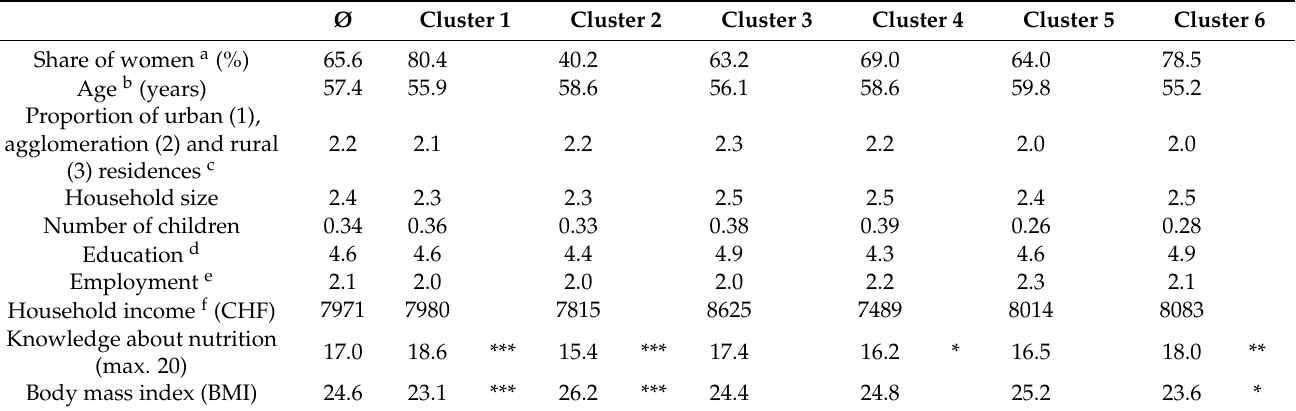
Table 3. Comparison of clusters with regard to their sociodemographic